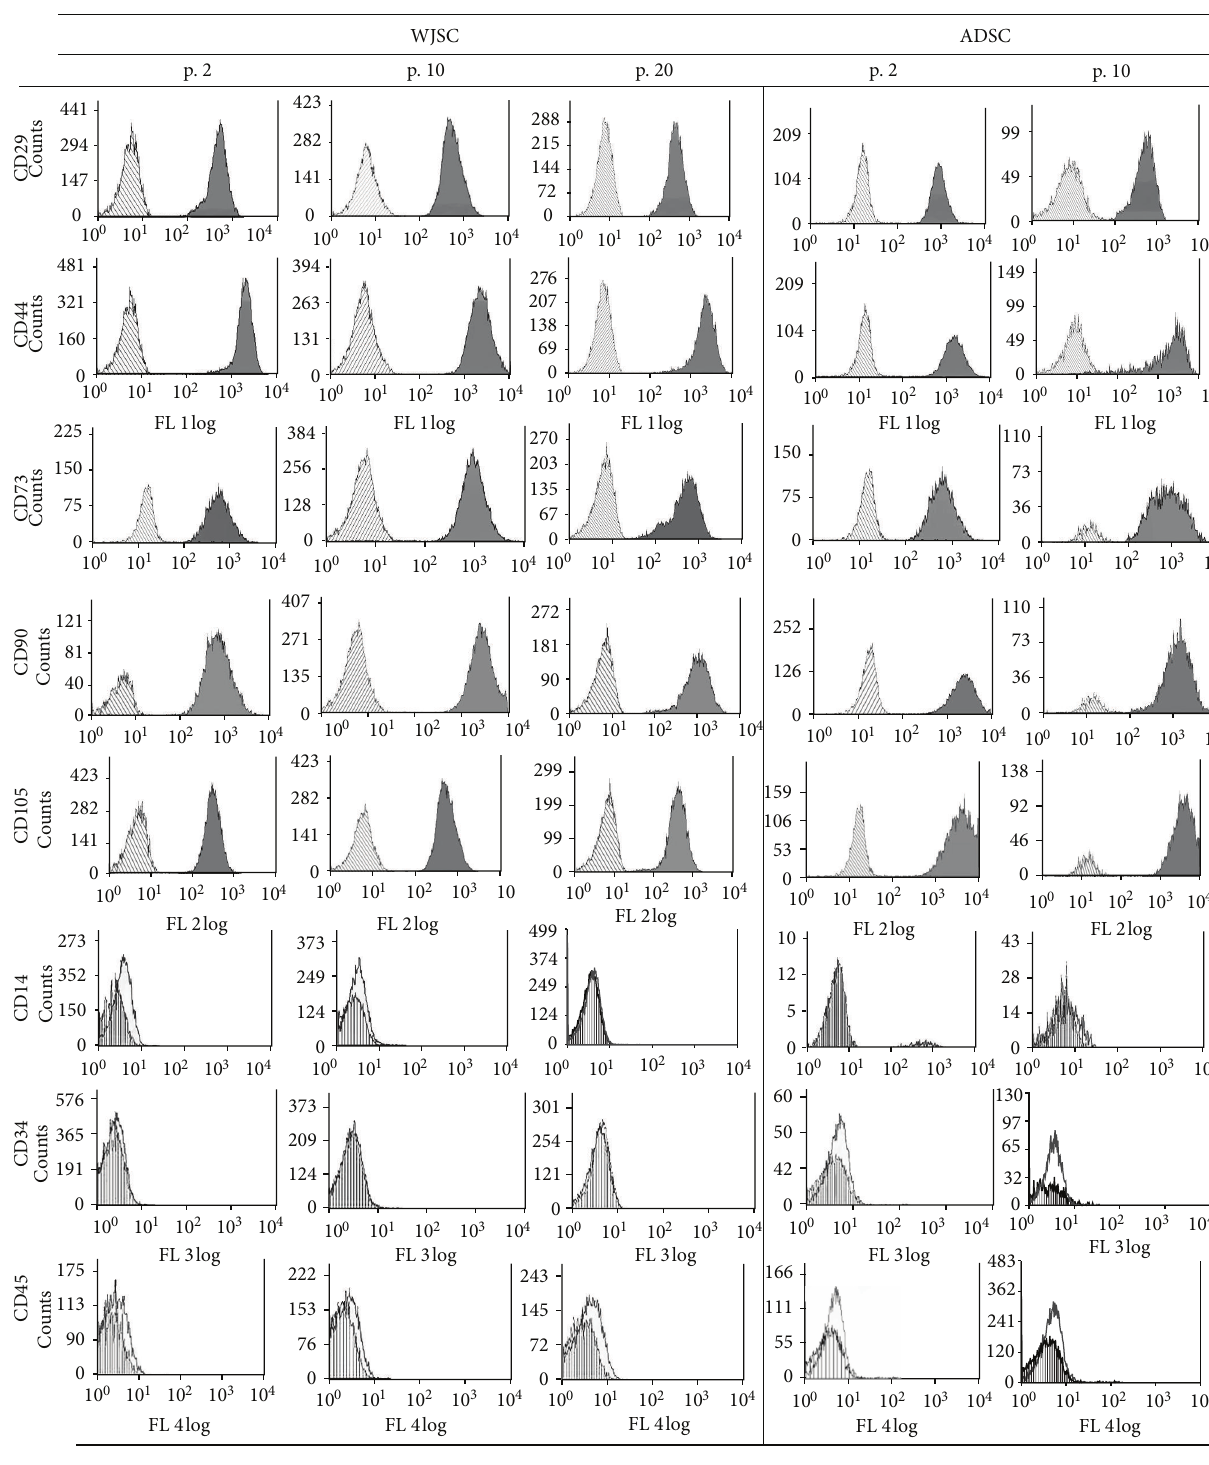
Figure 4: Immunophenotypic analysis of WJSC and ADSC for the expression of typical mesenchymal and hemopoietic stem cell surface markers (first five and last three markers, resp.) during subculture. The vertical axes of the histograms depict event counts, and the horizontal axesrepresentfluorescenceintensitiesofsurface-boundconjugates,thatis,markerexpressionlevels.StainingofWJSCandADSCwithspecific monoclonal antibody conjugates is illustrated by solid dark histograms (MSC markers: CD-29 and -44 FITC; CD-73, -90, and -105 PE) and by open histograms (HSC markers: CD-14 and -34 ECD; CD-45 PC5). Stripped histograms correspond to isotype-matched (negative)